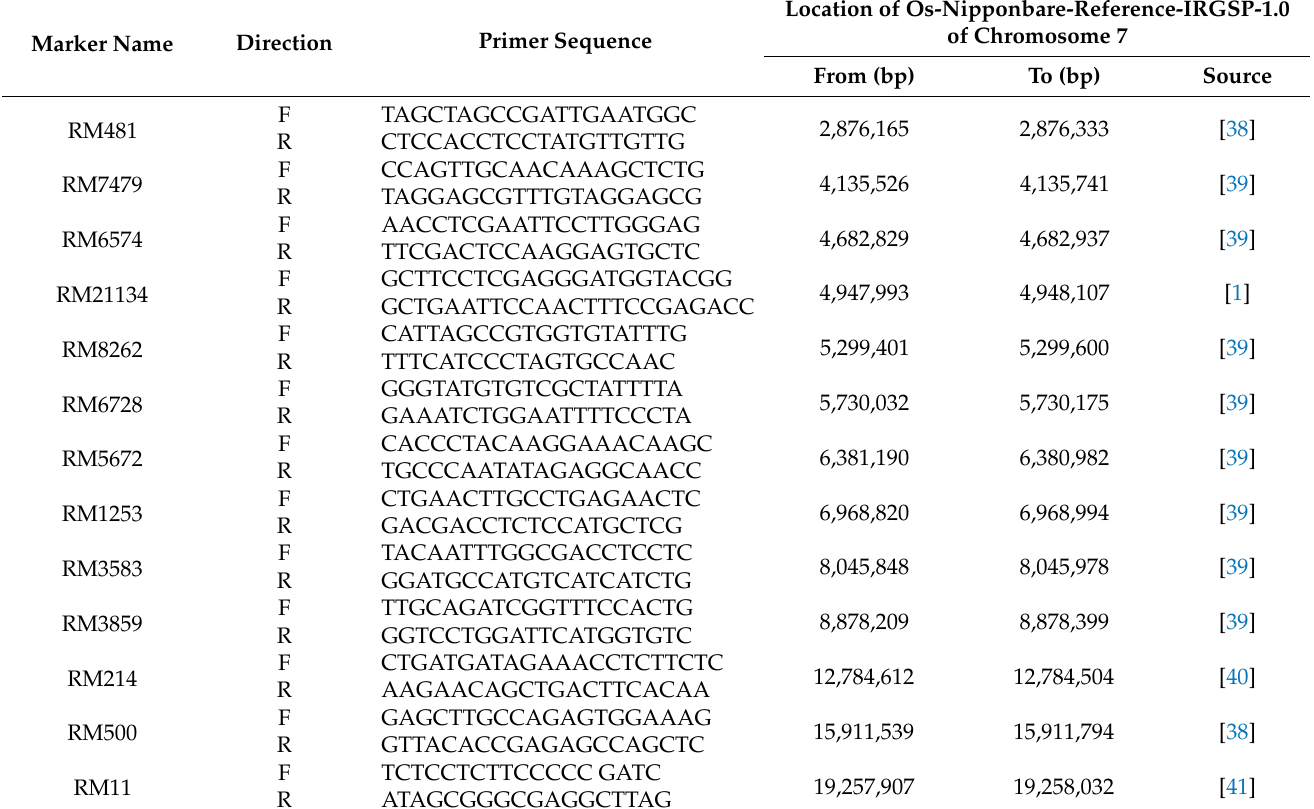
Table 1. Primer sequences of DNA markers for linkage analysis of xa19